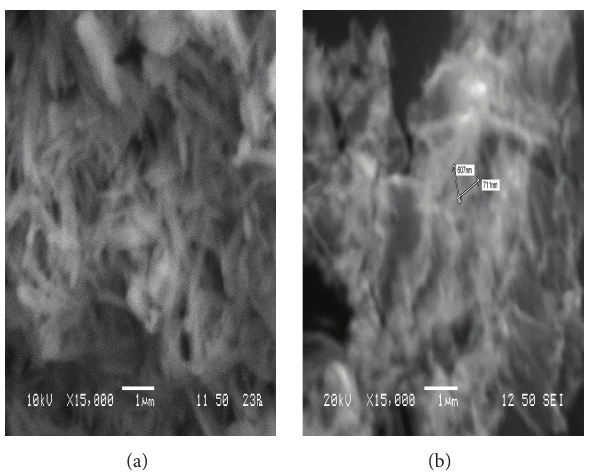
Figure 5: SEM cellulose nanowhiskers micrographs. (a) Commercial MCC nanowhiskers, (b) nopal CNWs.